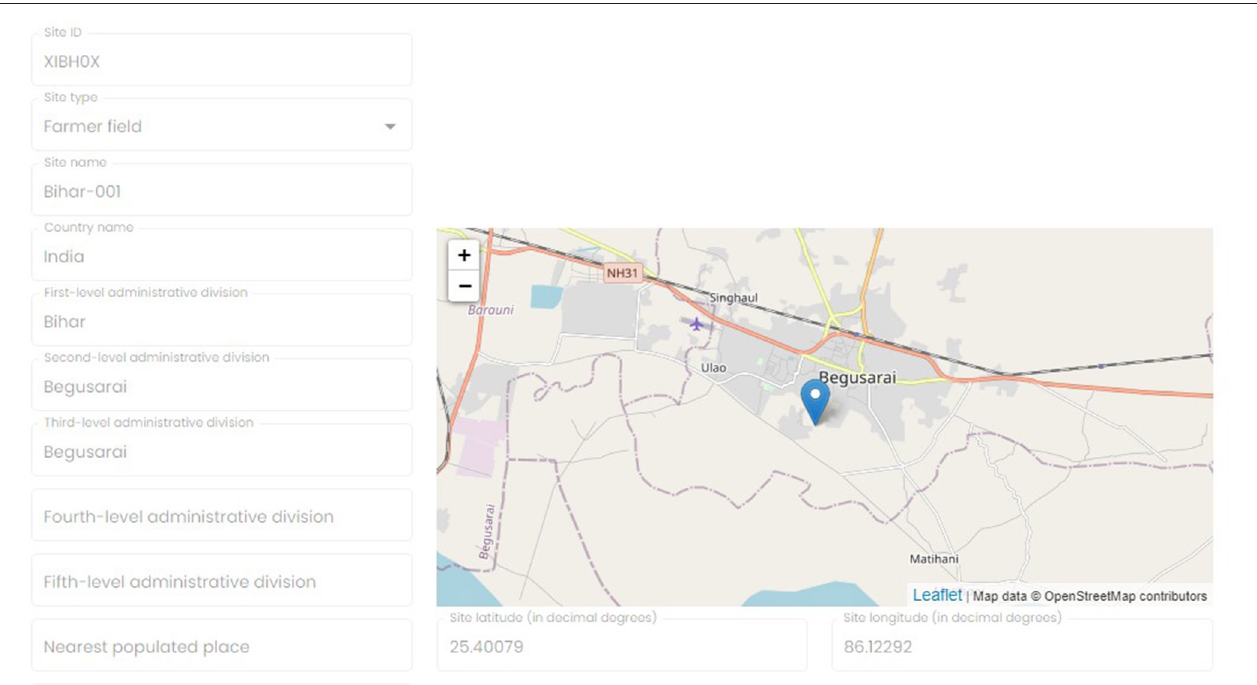
FIGURE 3 | Sites can be specified by choosing country and administrative divisions from an authoritative database connected into AgroFIMS, or by dropping a pin on a map. tool that is developed on top of Angular 11.0, a single